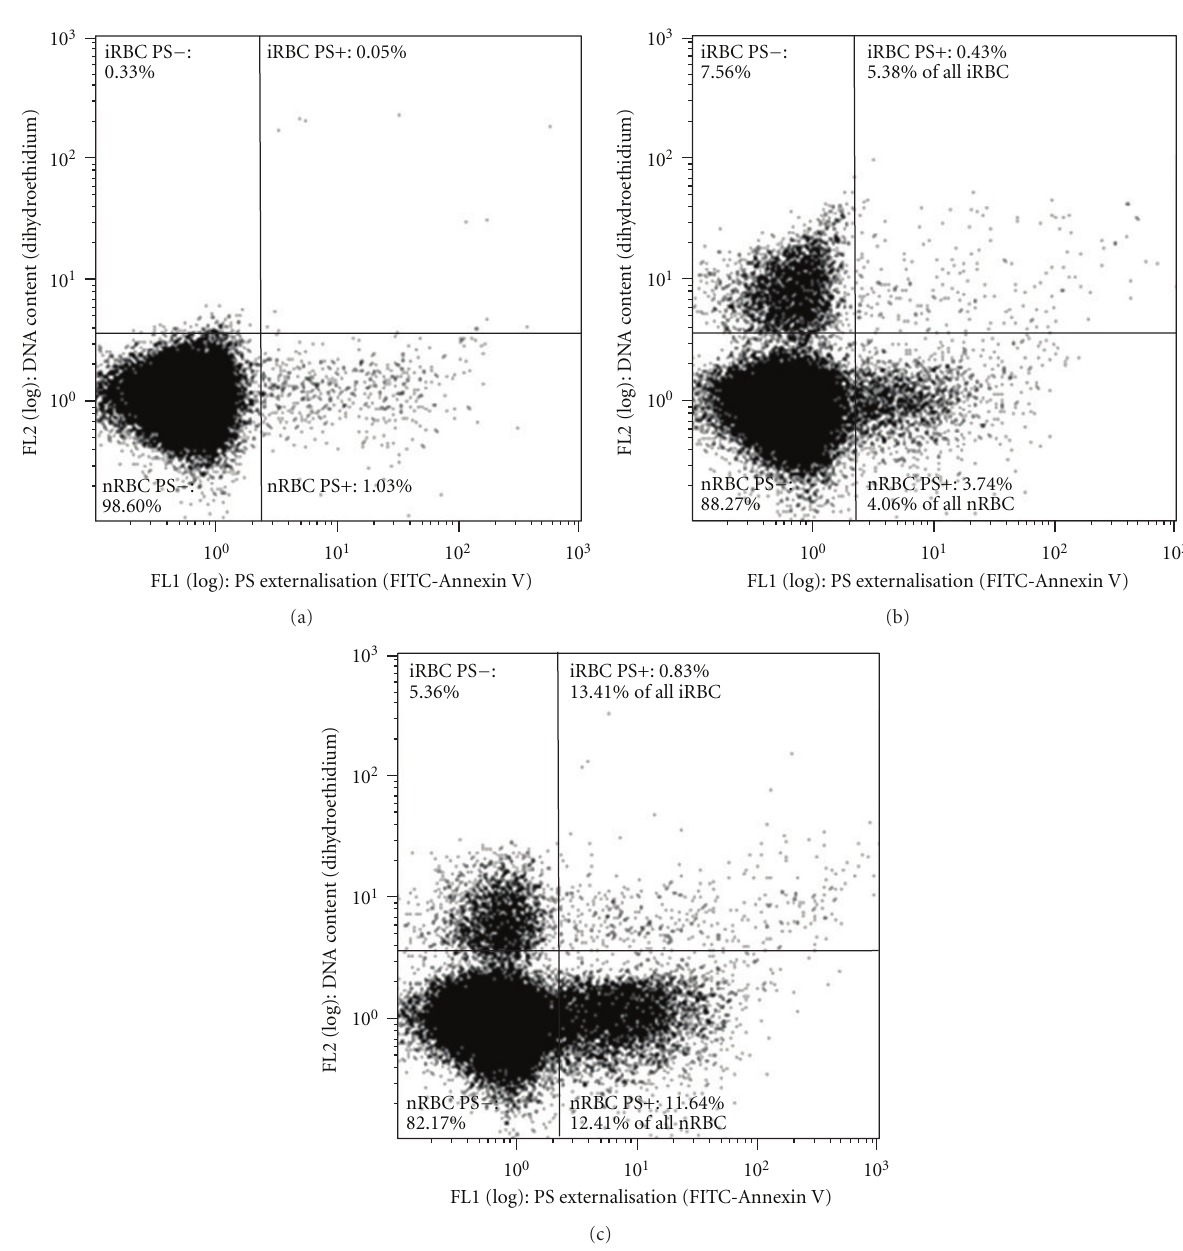
Figure 2: Phosphatidylserine externalisation (PS+) measured by FITC-Annexin V binding in both infected erythrocytes (iRBC) and their neighbouring noninfected erythrocytes (nRBC). iRBC were identified by the uptake of the cell-permeable DNA-binding dye dihydroethidium. An increase in PS externalisation can be seen by comparing an uninfected erythrocyte culture (a), to a parasite culture (b), both maintained at 37 ◦ C, and a heat-stressed parasite culture maintained at 40 ◦ C for 48 hours